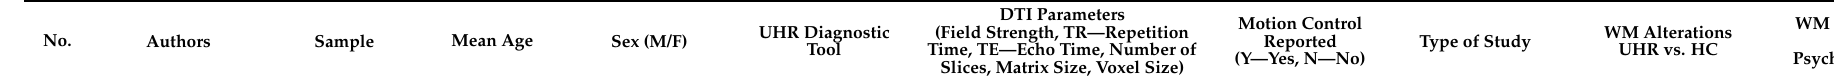
PLSC: Trend-level interaction between FA and cognitive performance Higher FA correlated with better cognitive performance (but not in